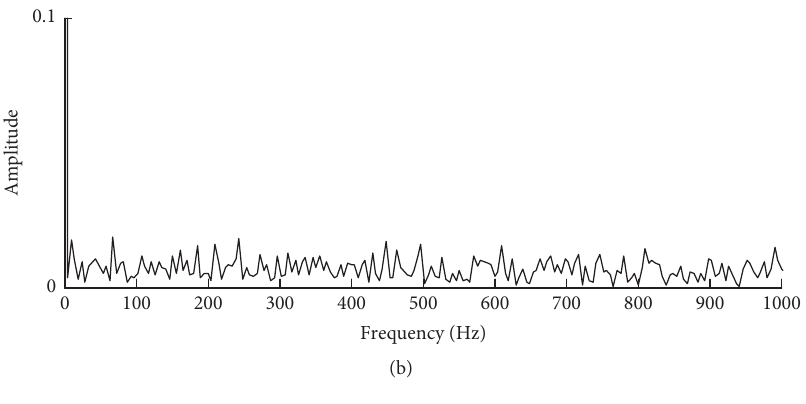
Figure 12: Fault signal and envelope spectrum of inner race fault.